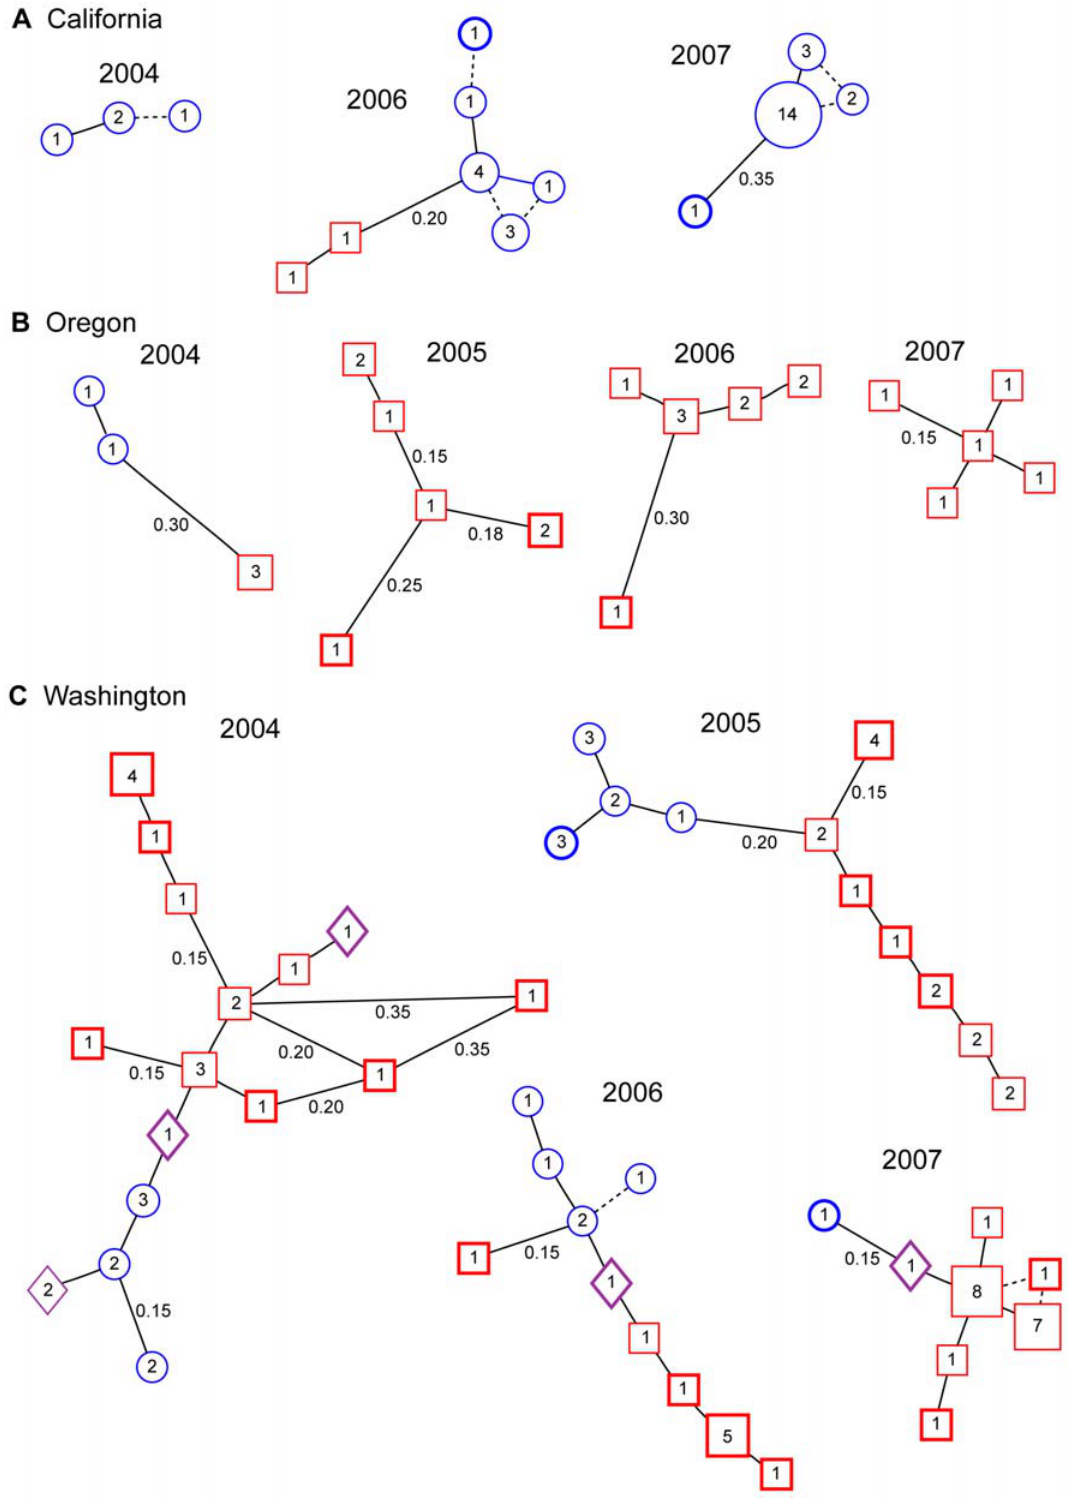
Figure 2. Minimum spanning networks for West Coast NA1 populations. A. California, B. Oregon, and C. Washington. For constructing the networks multilocus genotypes were collapsed to multilocus haplotypes, which are represented by circles, squares, or diamonds containing the number of associated isolates and sized in proportion to haplotype frequency. Blue circles and red squares represent the two different groups identified by Structure. Purple diamonds are haplotypes that could not be assigned to one group or the other with high confidence ( . 75% probability). Bolded haplotypes are those that were found in only that state (some haplotypes found only in Washington were seen in multiple years). Branches are proportional to Bruvo et al. ’s [56] genetic distance and are labeled with distance if different than 0.10. Broken lines connect haplotypes that only differ by null alleles at one locus. Loops in the networks indicate multiple tied minimum spanning trees.